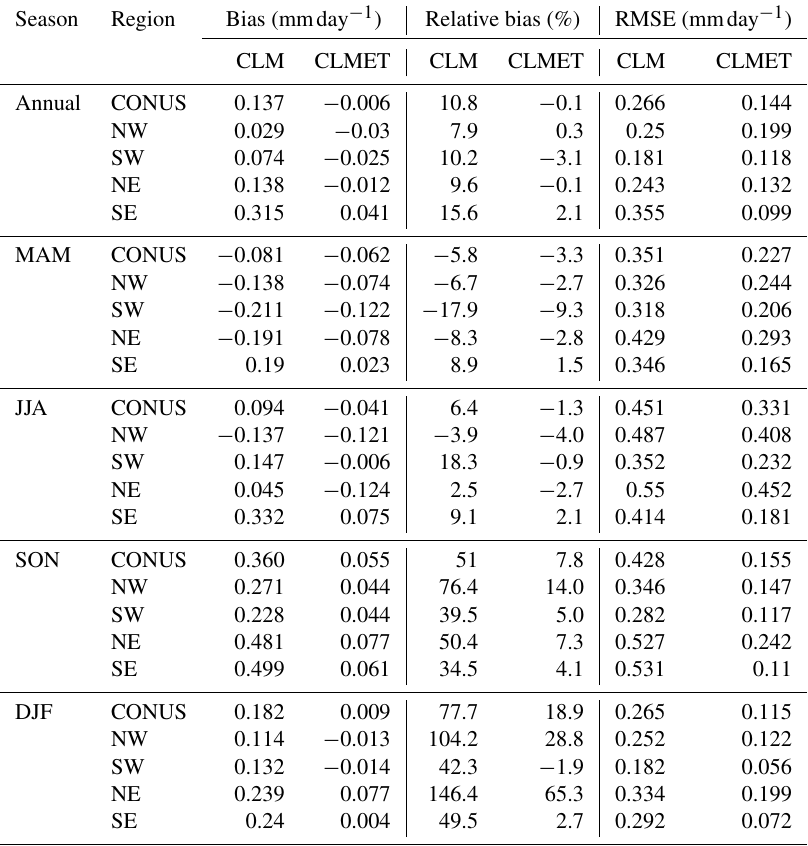
Table 1. Spatial evaluations of simulated ET from two different types of runs (CLM and CLMET) against GLEAM-derived ET over the CONUS, Northwest (NW), Southwest (SW), Northeast (NW), and Southeast (SW) annually and seasonally during the period